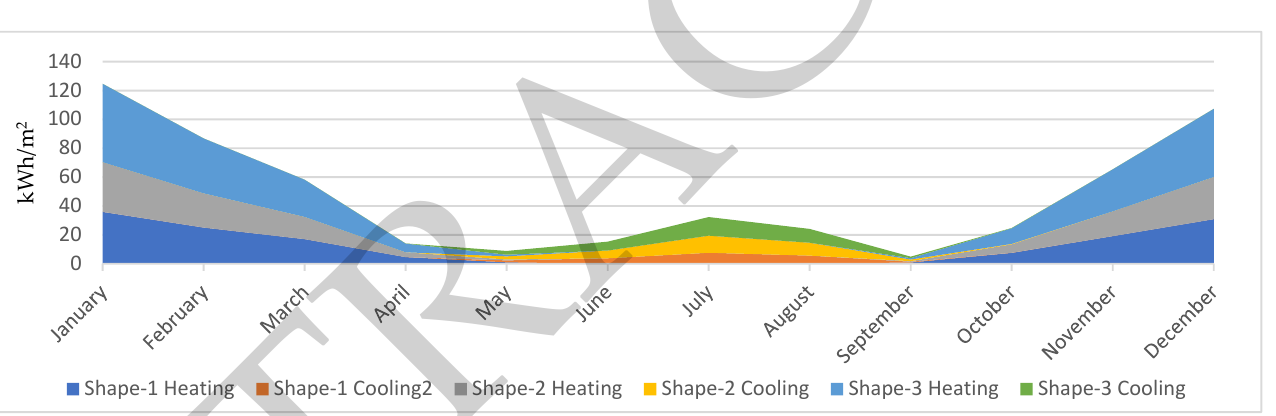
Figure 12. Monthly heating and cooling energy consumption in Harbin.